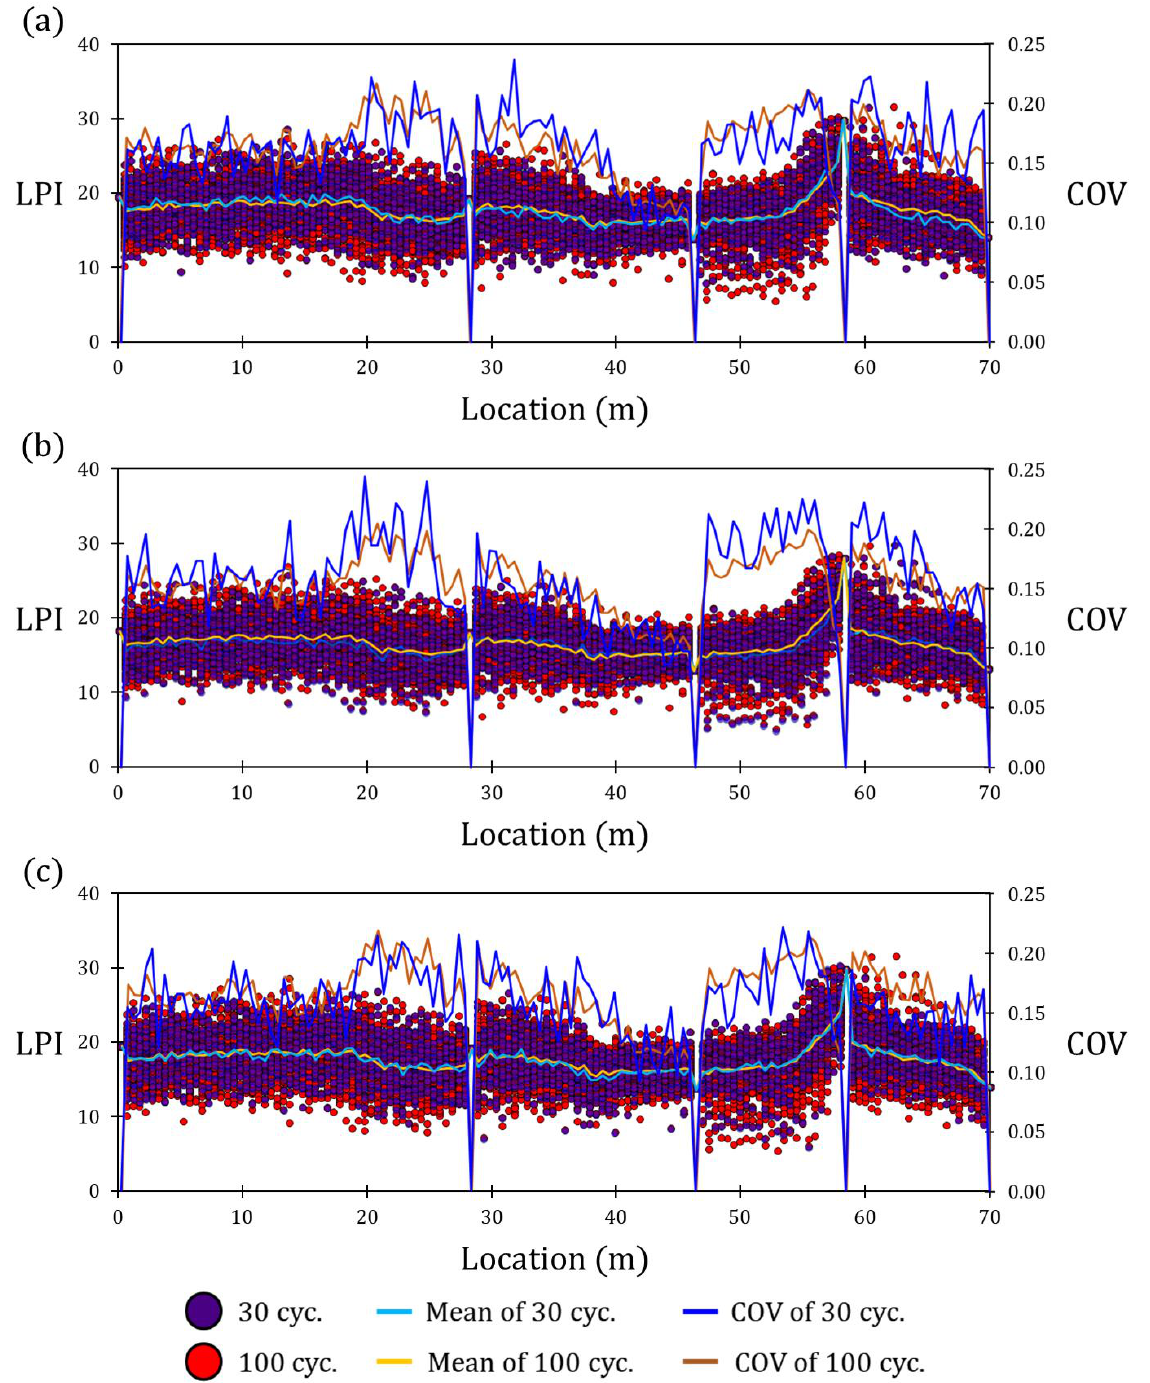
Figure 12. Comparison of 30 and 100 cycles of liquefaction-potential evaluations of the CMC random- field-parameter model through the HBF method. ( a ) Realization 1. ( b ) Realization 2. ( c ) Realization